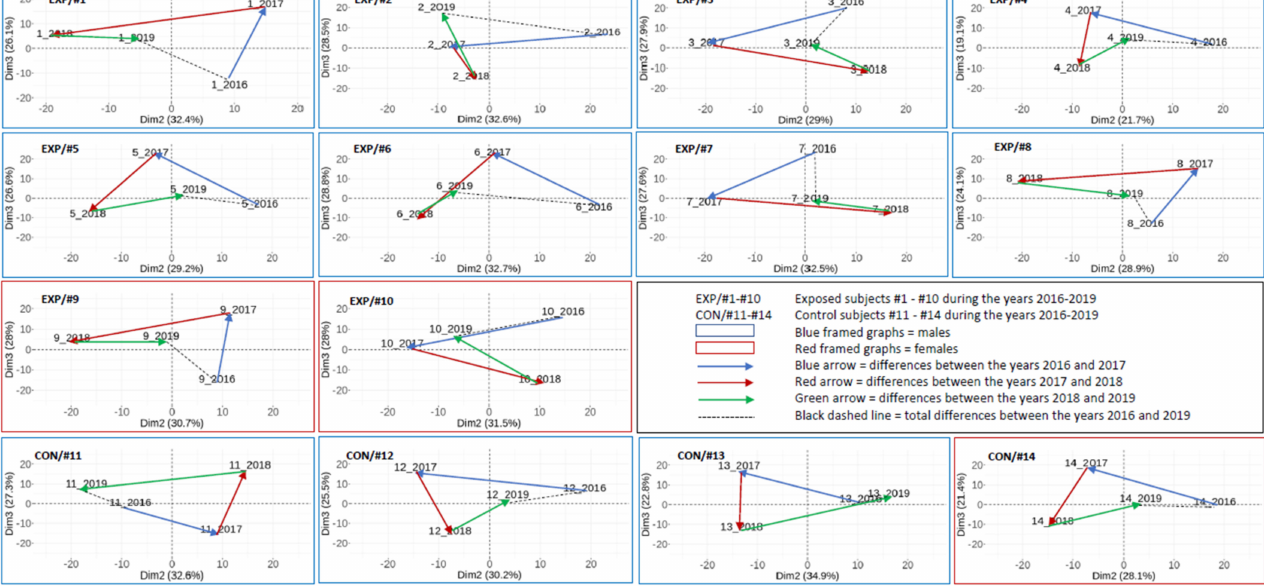
Figure 4. Individual DNA methylation pattern trajectories of the exposed and control subjects analyzed by PCA in four consecutive years: results of the selected 705 CpG data set analyzed by array chips. Three-year differences between the years 2016 and 2019 (dashed line) were used for the calculations of the range of changes in the exposed and control subjects (details in Section